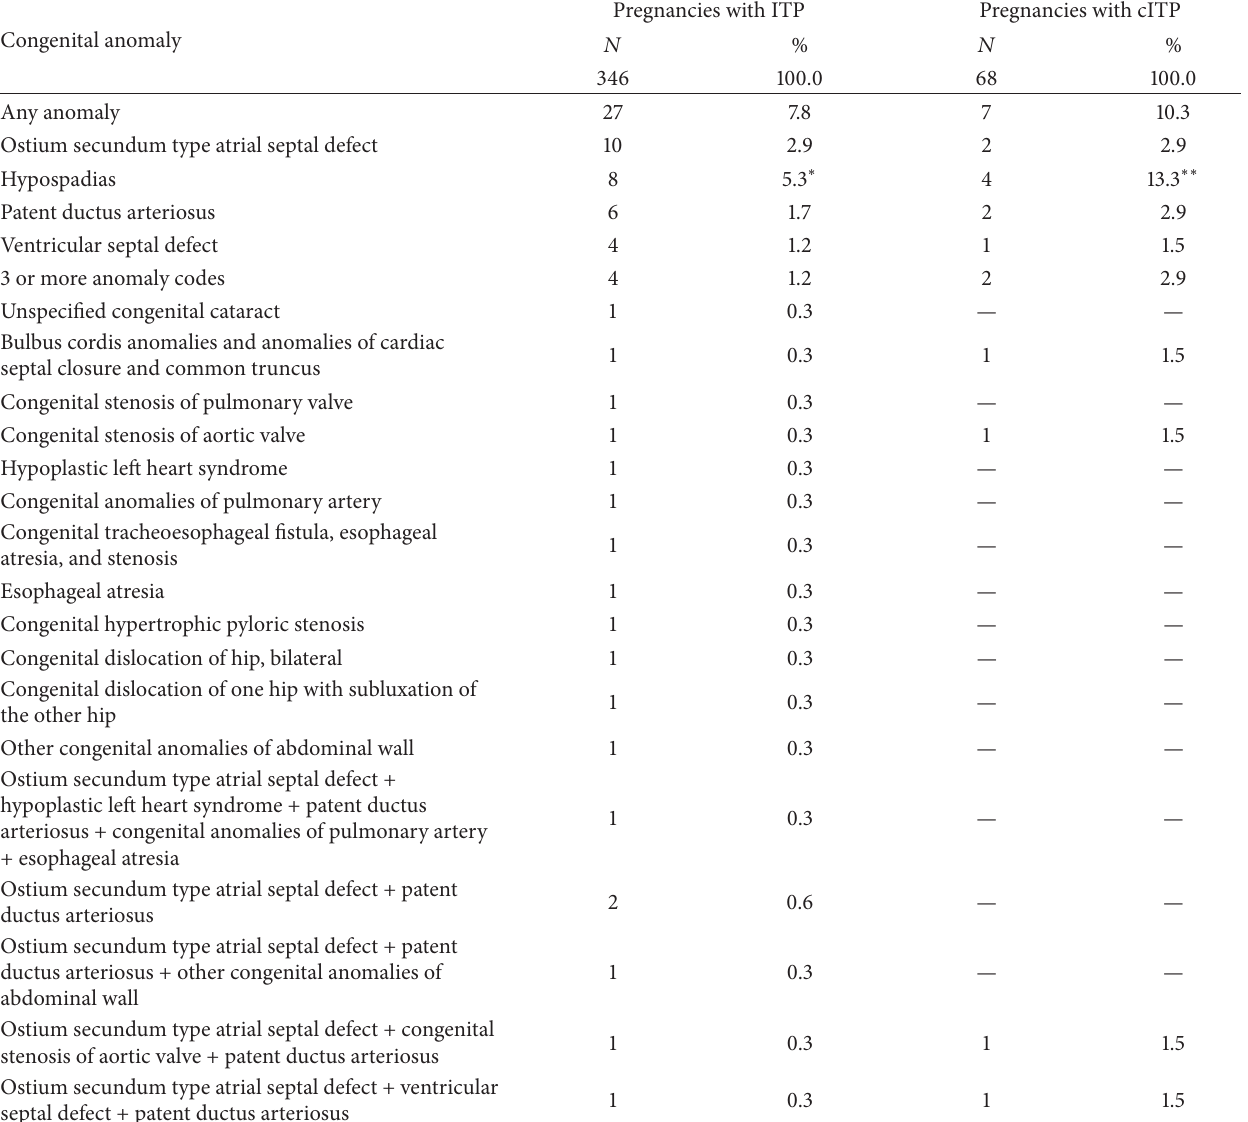
Table 3: Claims-based congenital anomalies among newborns of women with ITP or cITP. Congenital anomaly